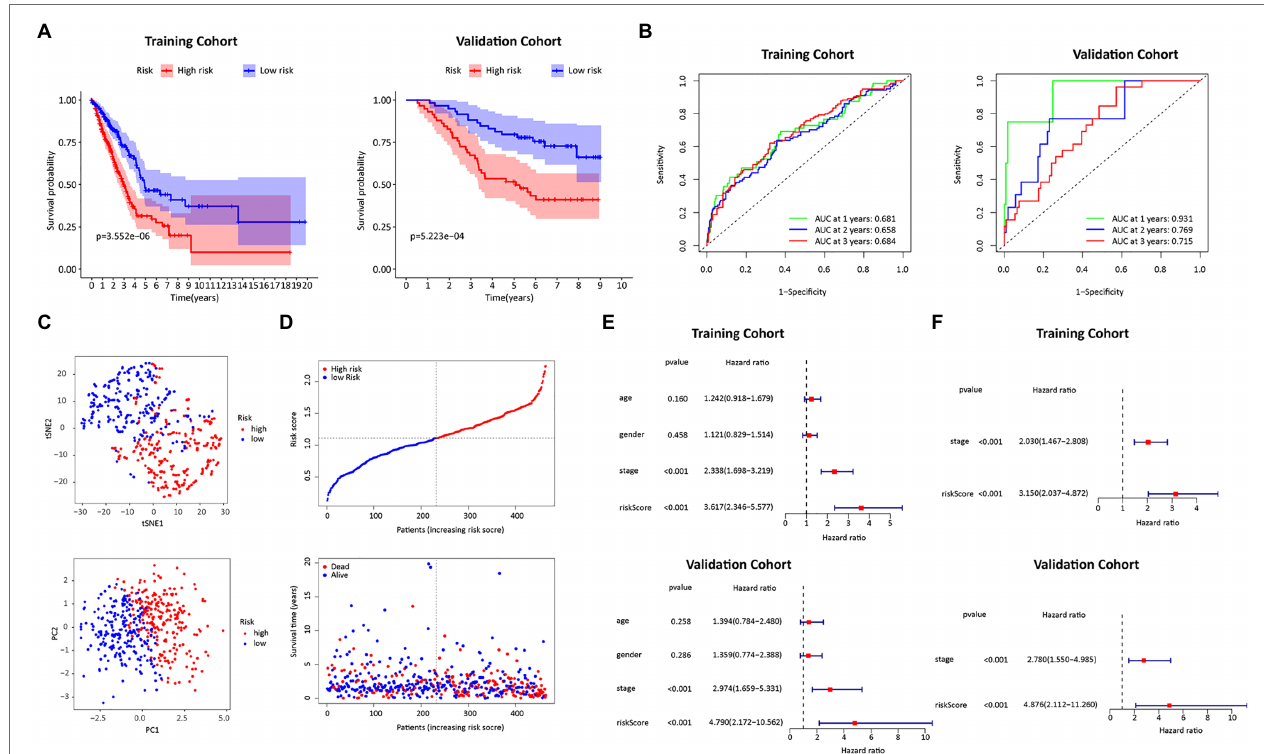
FIGURE 3 | Construction and validation of the FRGs risk score formula. (A) Kaplan Meier survival curves for the TCGA training cohort and the GEO validation cohort. (B) ROC curves of the FRGs risk score formula in the training and validation cohorts. (C) T-SNE analysis and PCA plot of the training cohort. (D) The risk and survival status plots in the training cohort. (E) Forest plot from the univariate Cox regression analysis in the training and validation cohort. (F) The results of multivariate analysis regarding OS in the training and validation